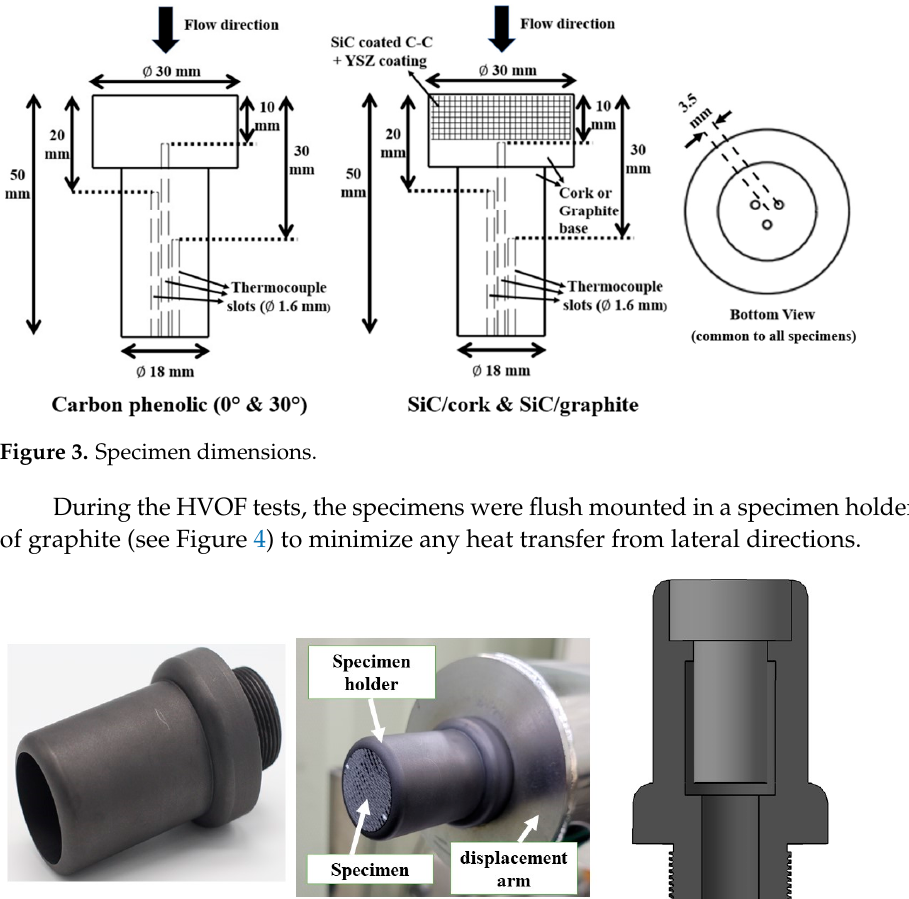
Figure 5. Experimental setup photograph. A two-color pyrometer (IMPAC series ISQ 5 model from LumaSense Technologies, Santa Clara, CA, USA with a measurement range from 1073.15 K to 3073.15 K) was used to measure the specimen stagnation point temperatures during the tests. An infrared (IR) camera (FLIR A655SC, theoretically, can measure up to 2273.15 K and measurements higher than 2273.15 K are also possible under certain conditions) was used to capture IR images of the specimen flow-facing surfaces during the tests. From IR camera images, specimen stagnation point temperatures were estimated and compared with the pyrome- ter data. The IR camera emissivity was set arbitrarily during the tests and later, during data analysis, the emissivity values were adjusted, until the IR camera temperature data matched with the pyrometer values. A camcorder and a high-speed camera were used to observe and record the specimen reactions during the tests. During the tests, three K-type thermocouples were used to measure the specimen internal temperatures. The National Instruments NI cRIO-9054 (a real-time embedded in- dustrial controller) with a thermocouple input module NI 9212 was used as the